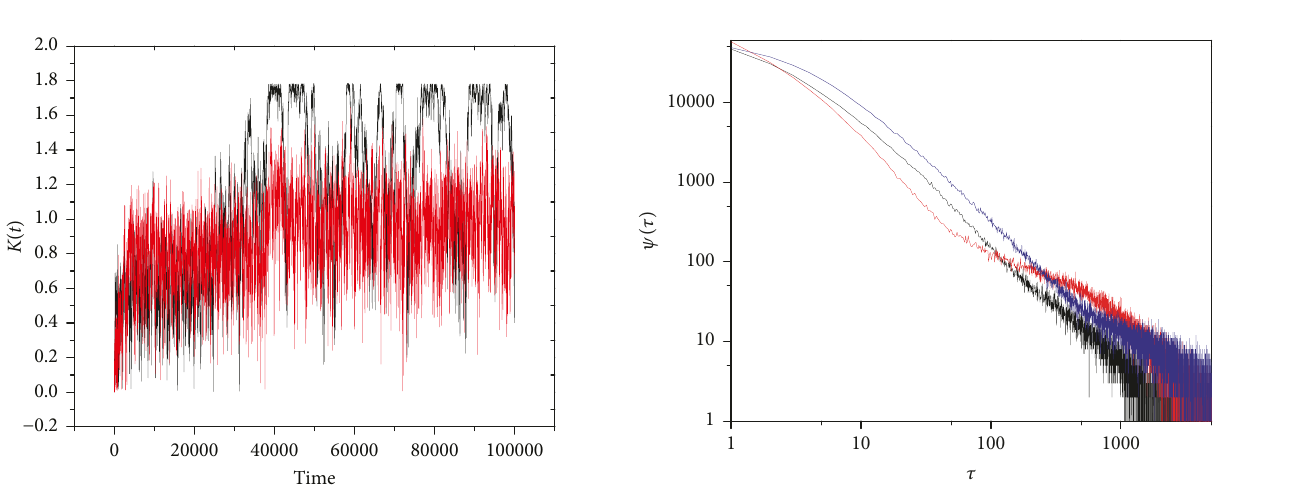
Figure 3: Black line: the time evolution 𝐾(𝑡) of (11) for the same regular two-dimensional network of Figure 1; red line: the time evolution of 𝐾(𝑡) of the self-organized system described by the black under the influence of the weak noisy perturbation described in Section 4.